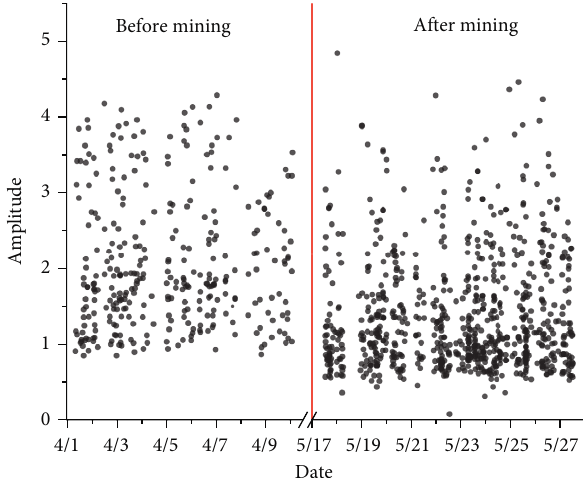
Figure 8: Comparison chart of microseismic events before and after mining.